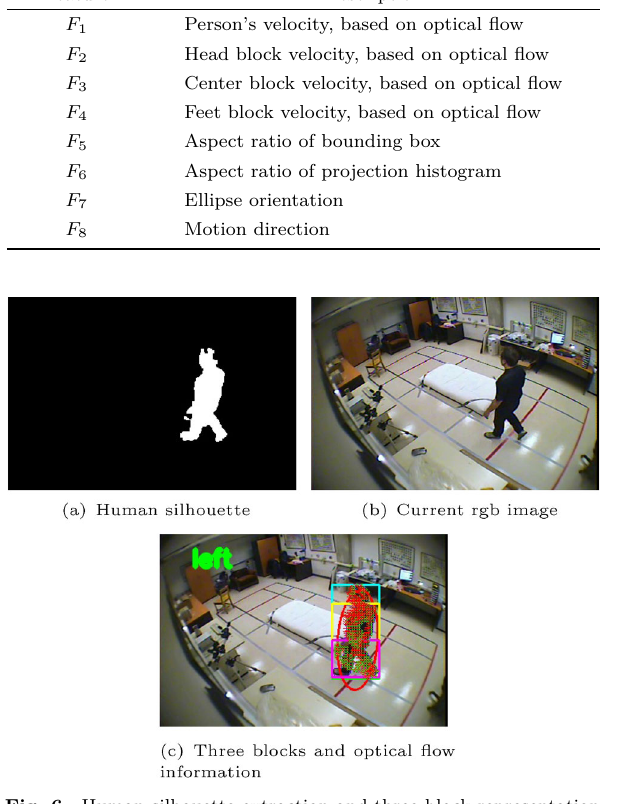
Fig. 6 Human silhouette extraction and three block representation. The word “left” in (c) indicates the person’s